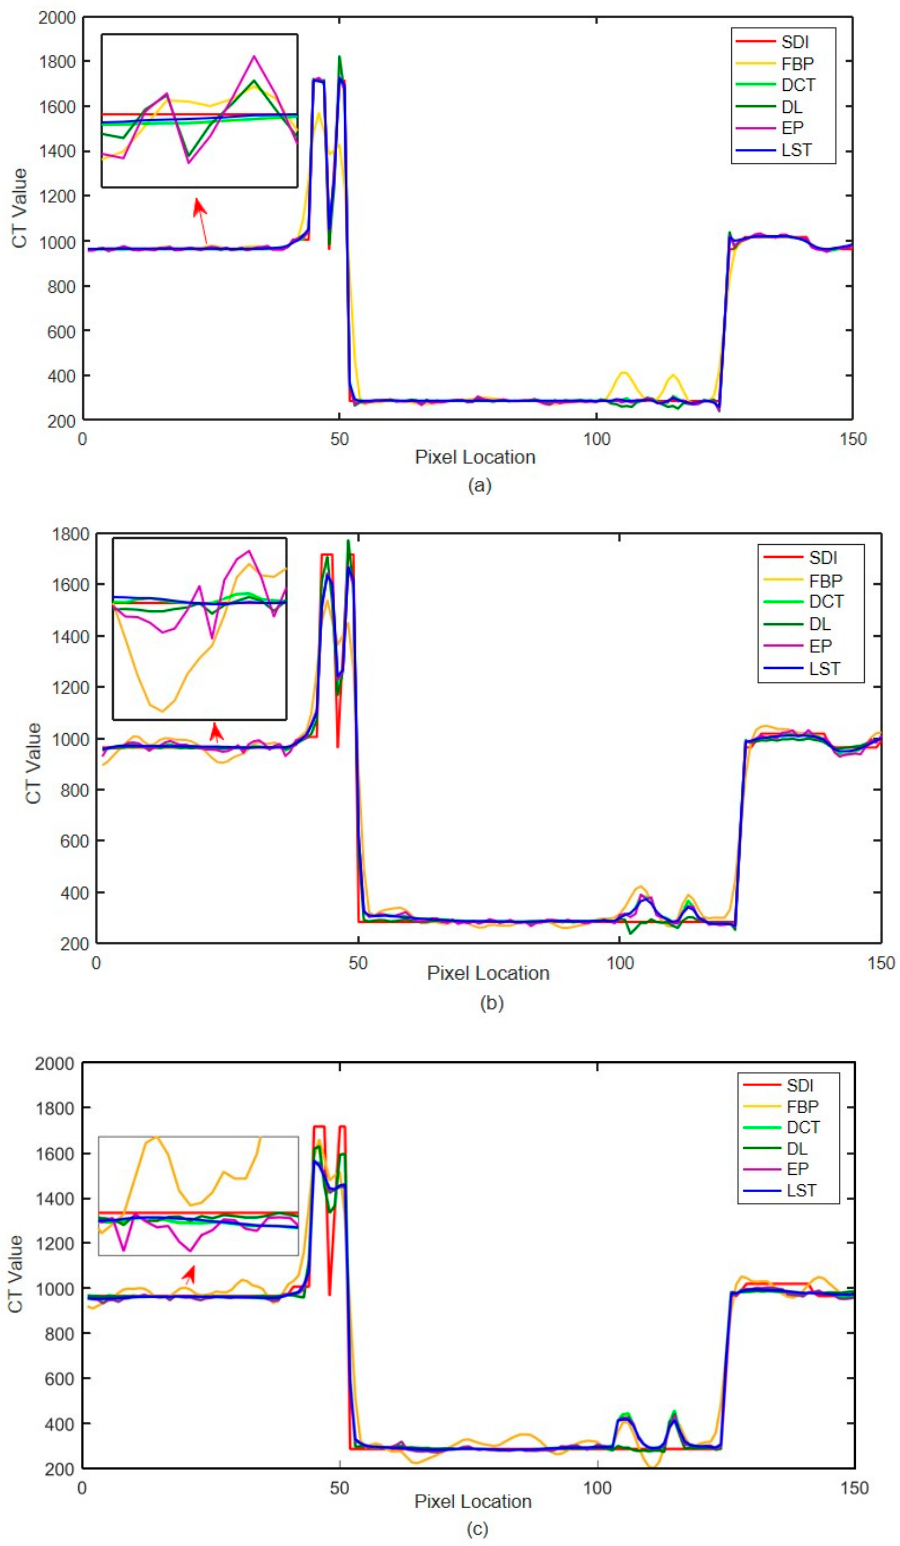
Figure 13. Local CT intensity curve. ( a ) The number of incident photons 10 5 ; ( b ) the number of incident photons 10 4 ; ( c ) the number of incident photons 5 × 10 3 Table 1. RMSE (HU) and SSIM of different algorithms.